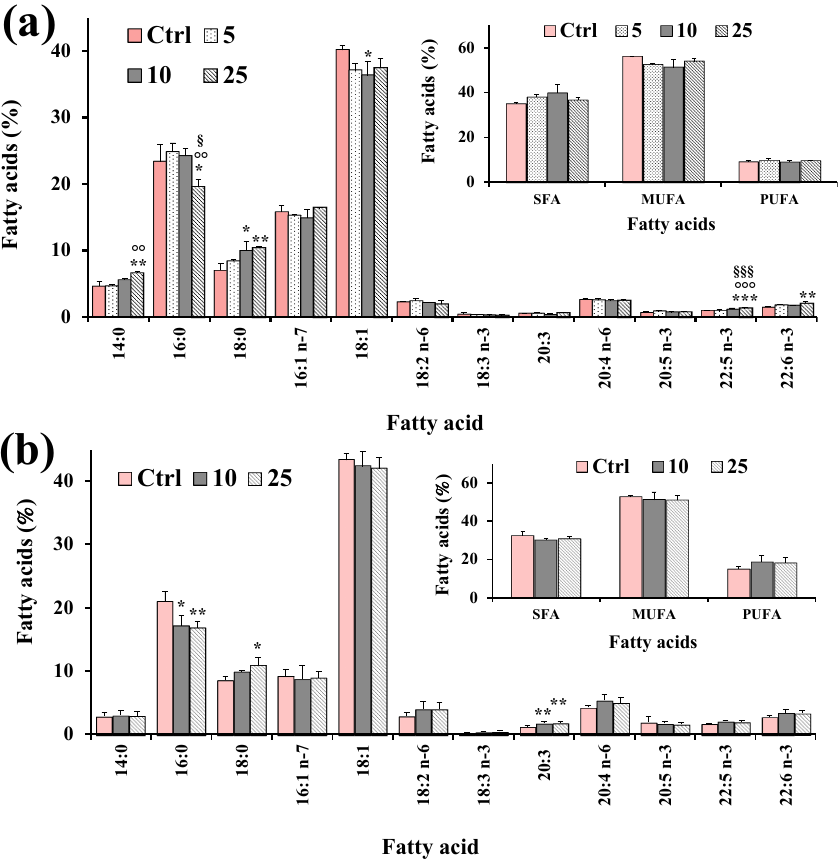
Figure 7. Values (expressed as % of total fatty acids) of the main fatty acids, total saturated (SFA), monounsaturated (MUFA) and polyunsaturated (PUFA) fatty acids measured in control HeLa cells (Ctrl) and cells treated for 24 h with XAN (5, 10 and 25 µ M) ( a ) and the reference compound eupatilin (EUP) (10 and 25 µ M) [6] ( b ). Three independent experiments and two replicates for each condition are performed, and data are presented as mean ± SD ( n = 6). *** = p < 0.001, ** = p < 0.01, * = p < 0.05 versus Ctrl; ◦◦◦ = p < 0.001, ◦◦ = p < 0.01 versus cells treated with XAN 5 µ M; §§§ = p < 0.001, § = p < 0.05 versus cells treated with XAN 10 µ M. Statistical significance of differences was assessed by One-way ANOVA and Bonferroni post Test.